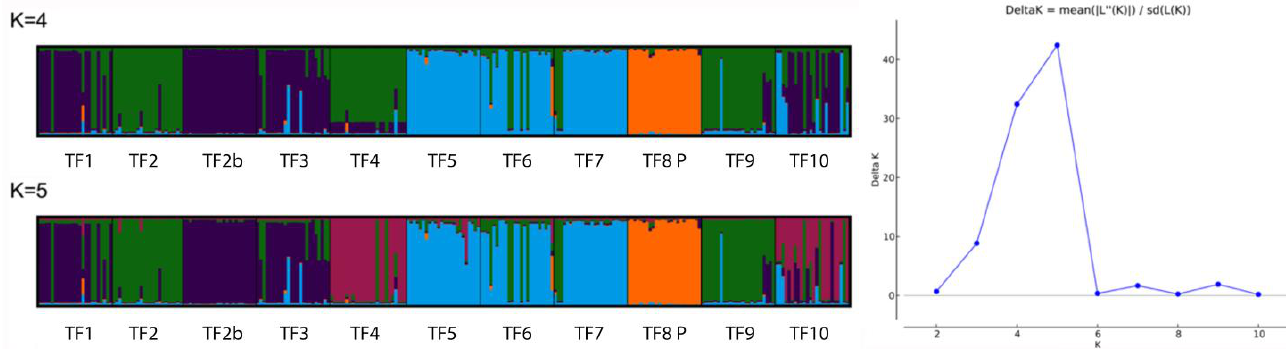
Figure 4. Plots of coefficients of membership for K = 4 and K = 5 (the most likely number of clusters as determined by the Δ K method).